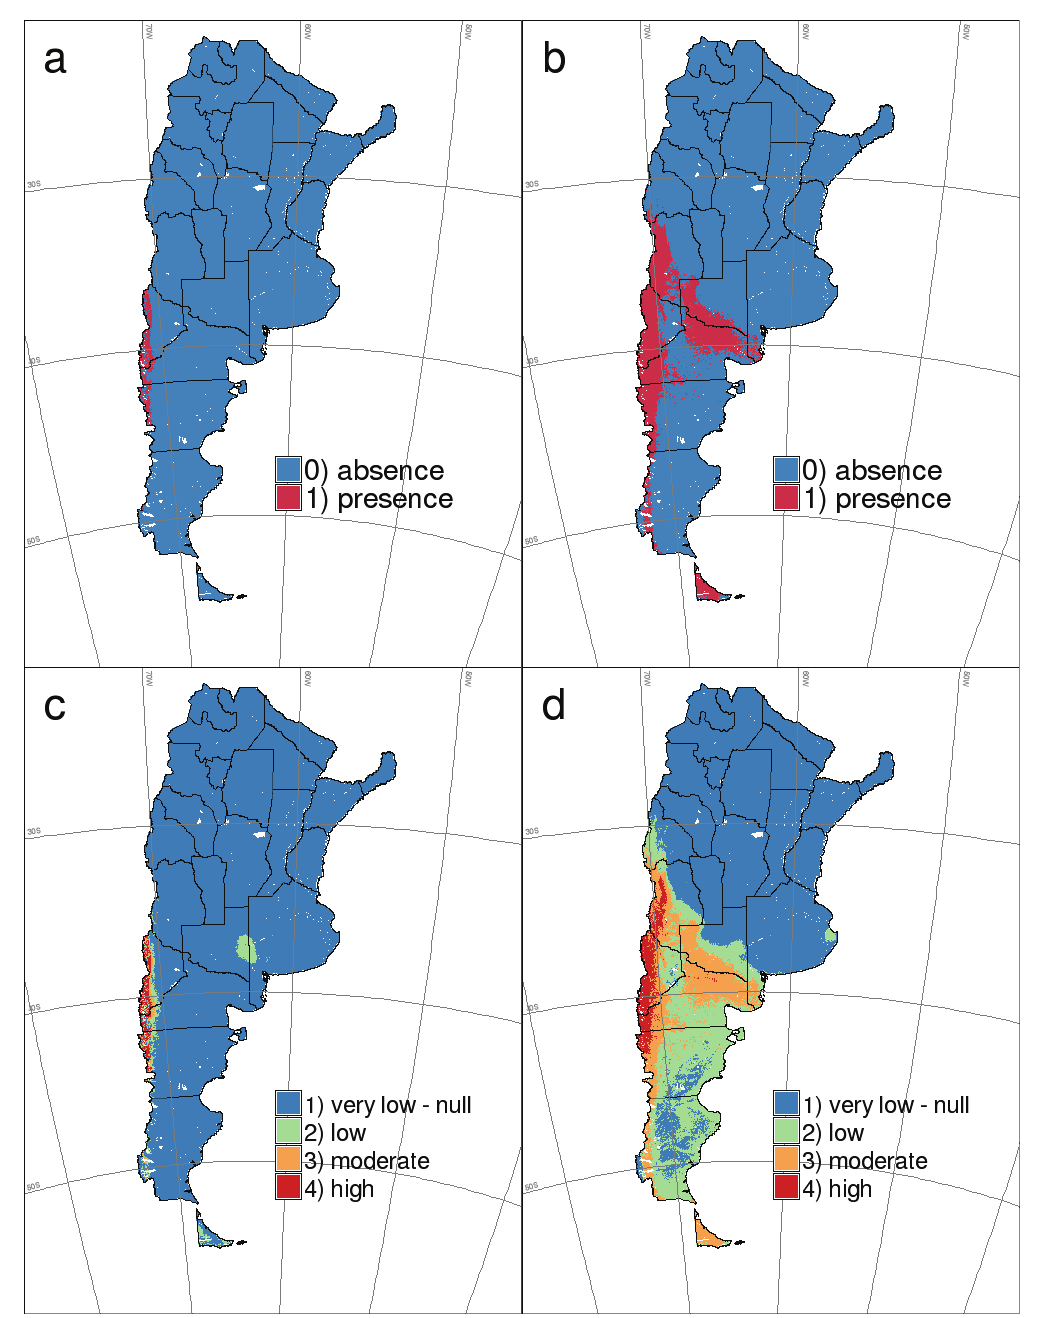
Figure 3. MaxEnt binary ( above ) and reclassified ( below ) maps for HPS cases by ANDV and O. longicaudatus presence in southern Argentina. ( a , c ) HPS by ANDV; ( b , d ) O. longicaudatus